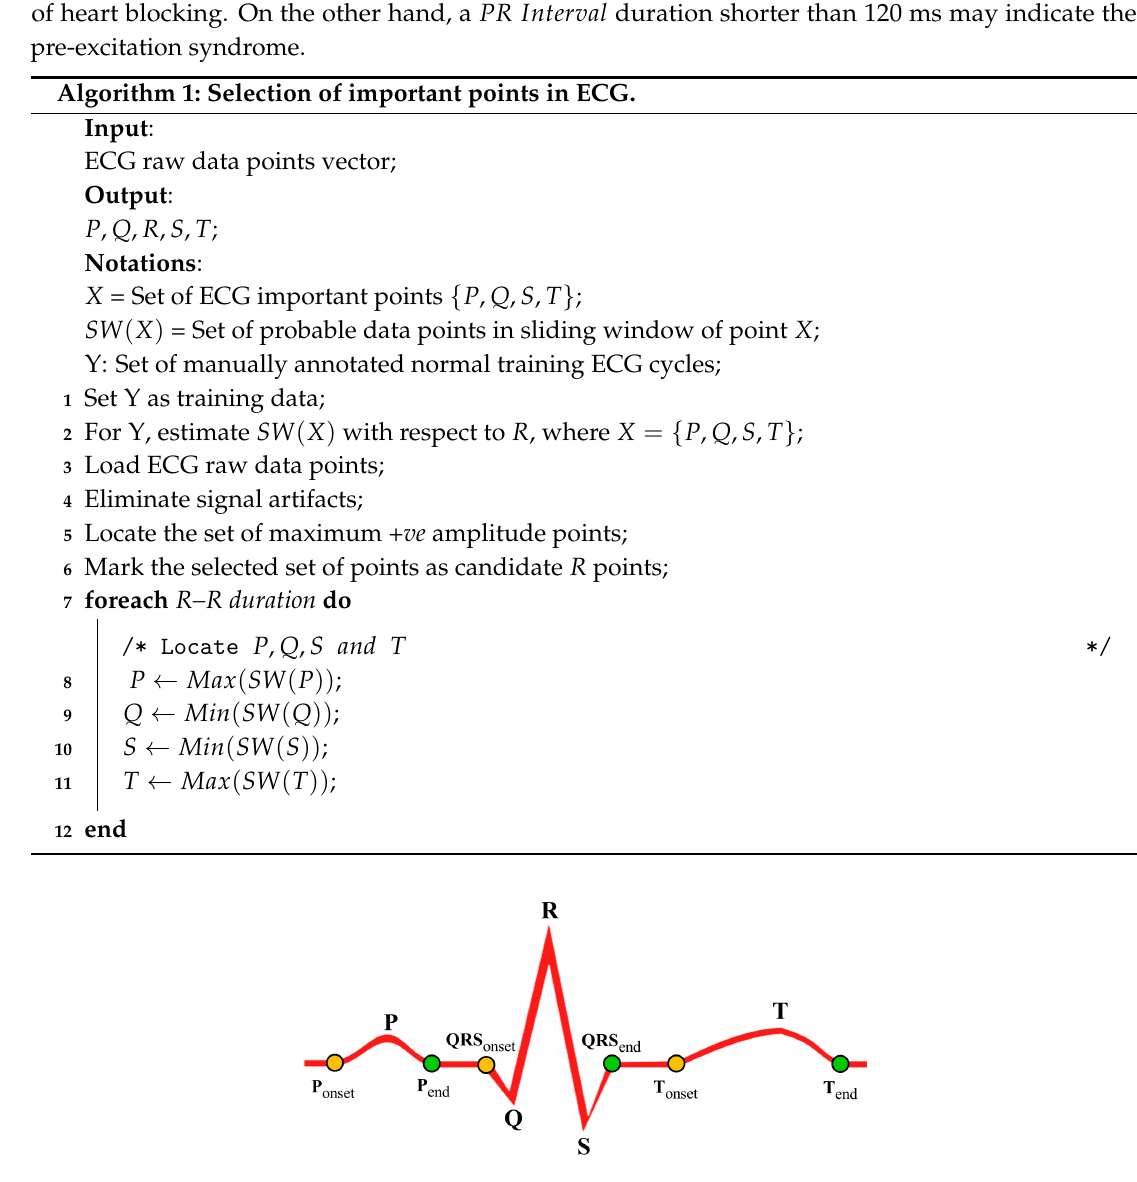
Figure 6. Example of important points, onset points and end points of ECG